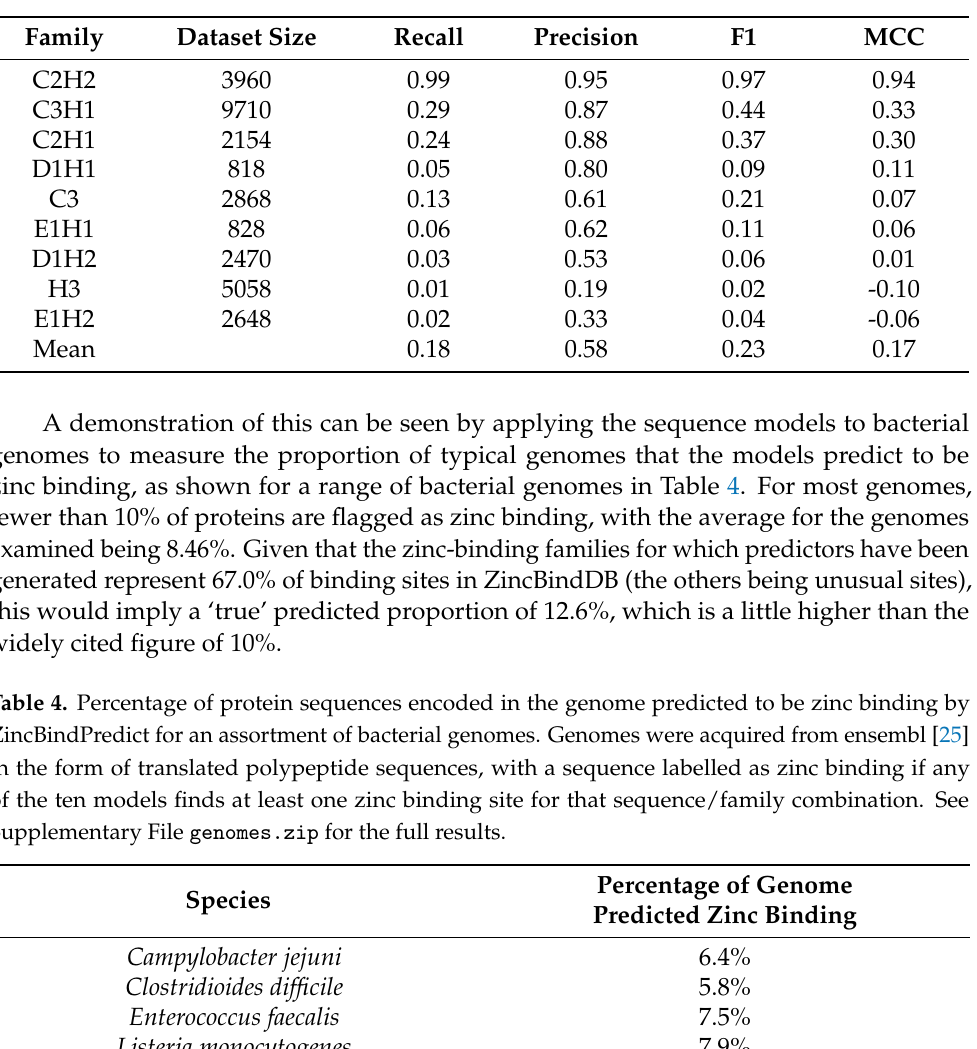
Table 3. Predictive ability of BLAST to identify zinc binding sites in protein sequences using homology alone.